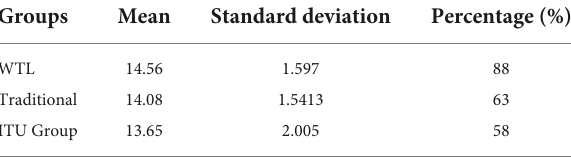
TABLE 4 Literacy and arithmetic test score.